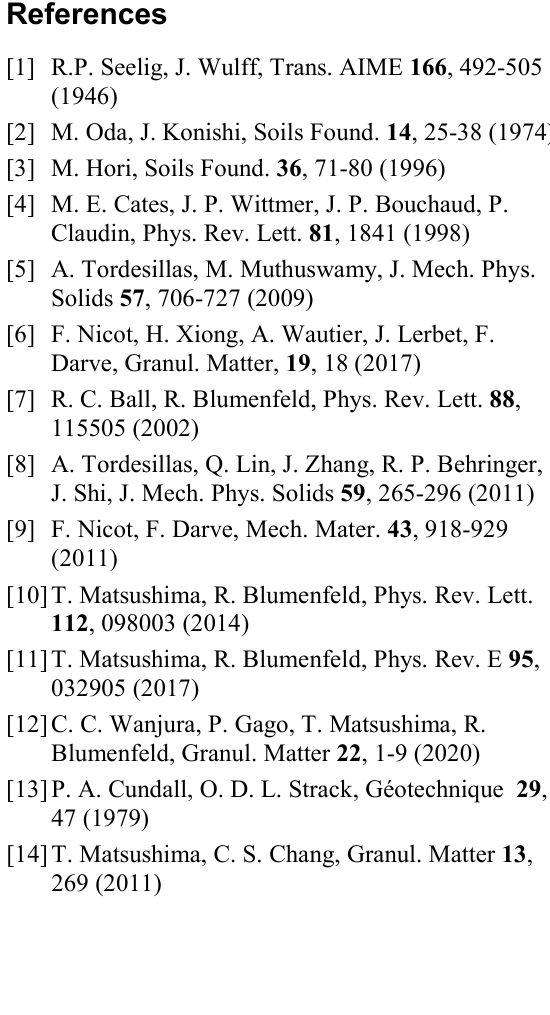
acting on each cell shown 𝒉𝒉 𝒉𝒉